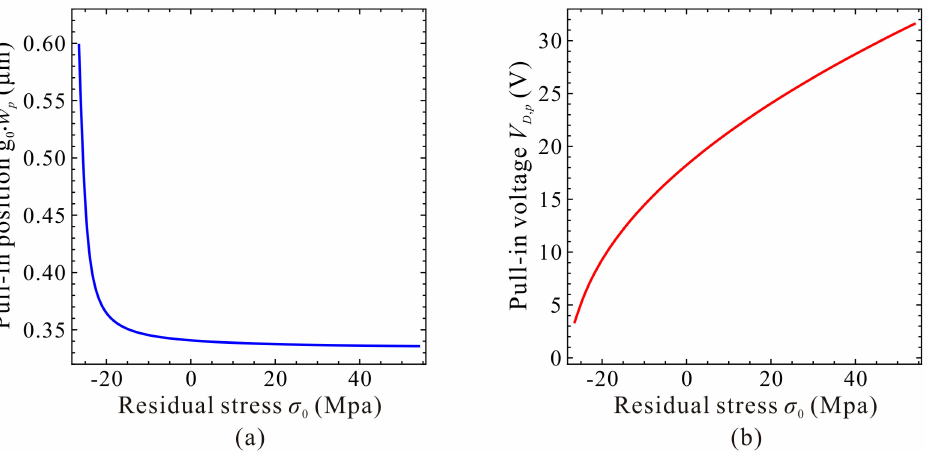
Figure 10. Qualitative property of the static pull-in position ( a ) and pull-in voltage ( b ) versus residual